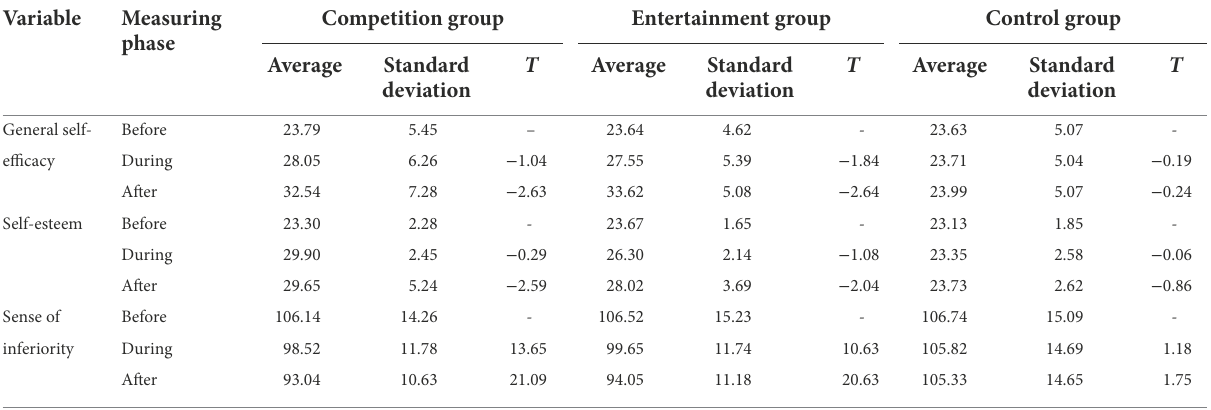
TABLE 7 Mean and standard deviation of the test and its relation to the pre-experiment T